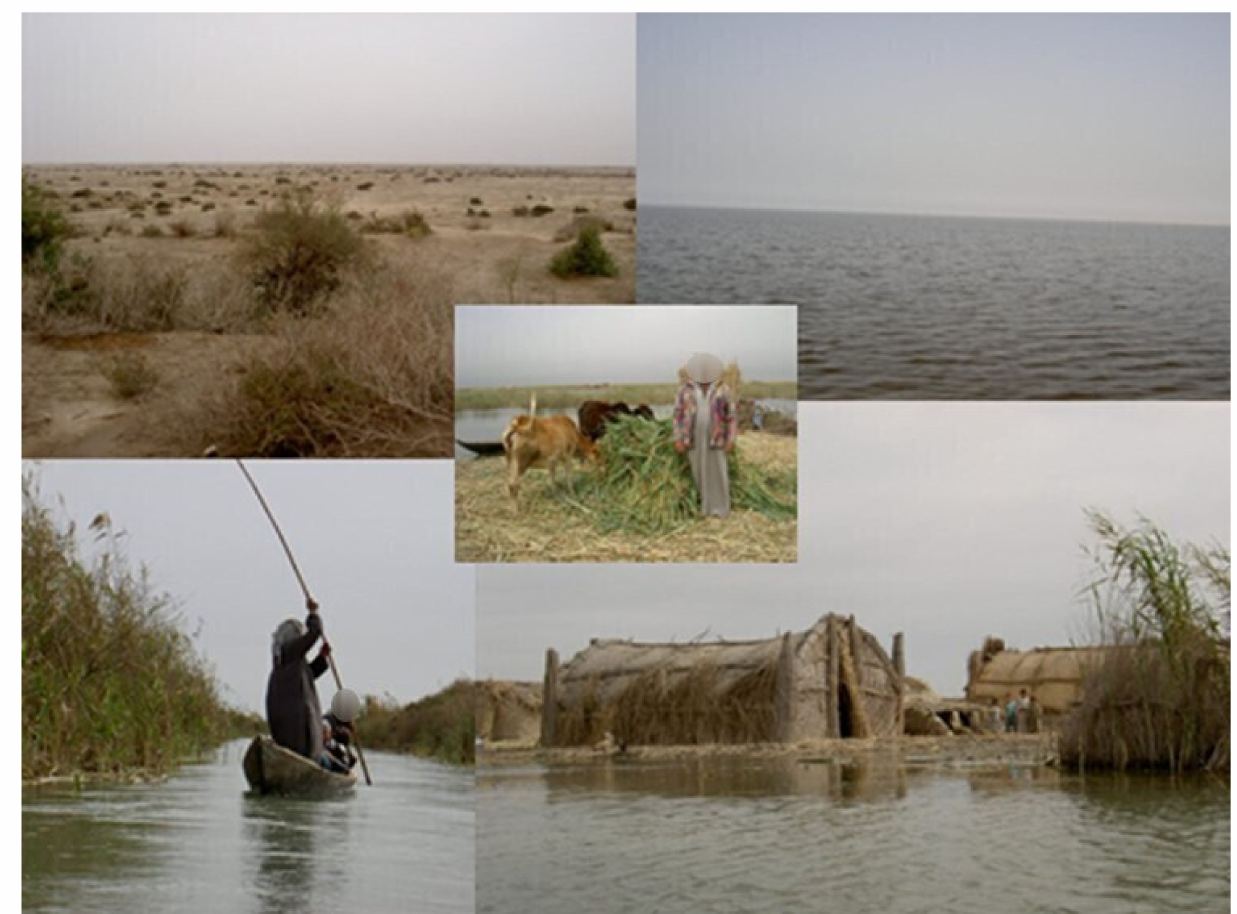
Figure 24. Mesapotamian wetlands. Desiccated landscape. Reflooded impoundment with limited biodiversity. Restored wetland within the natural floodplain landscape with traditional canoe, reed housing and animal husbandry. Source: Edward